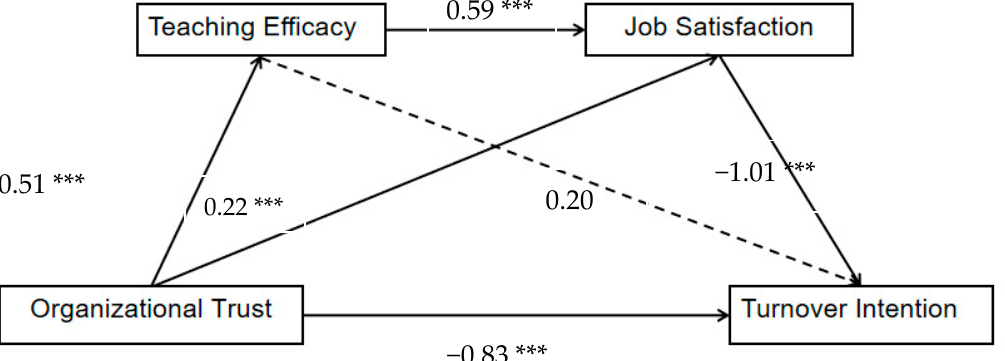
Figure 1. Mediator model examining the indirect relationship between organizational trust and turnover intention through teaching efficacy and job satisfaction. Note: Observations = 313. *** p < 0.001.